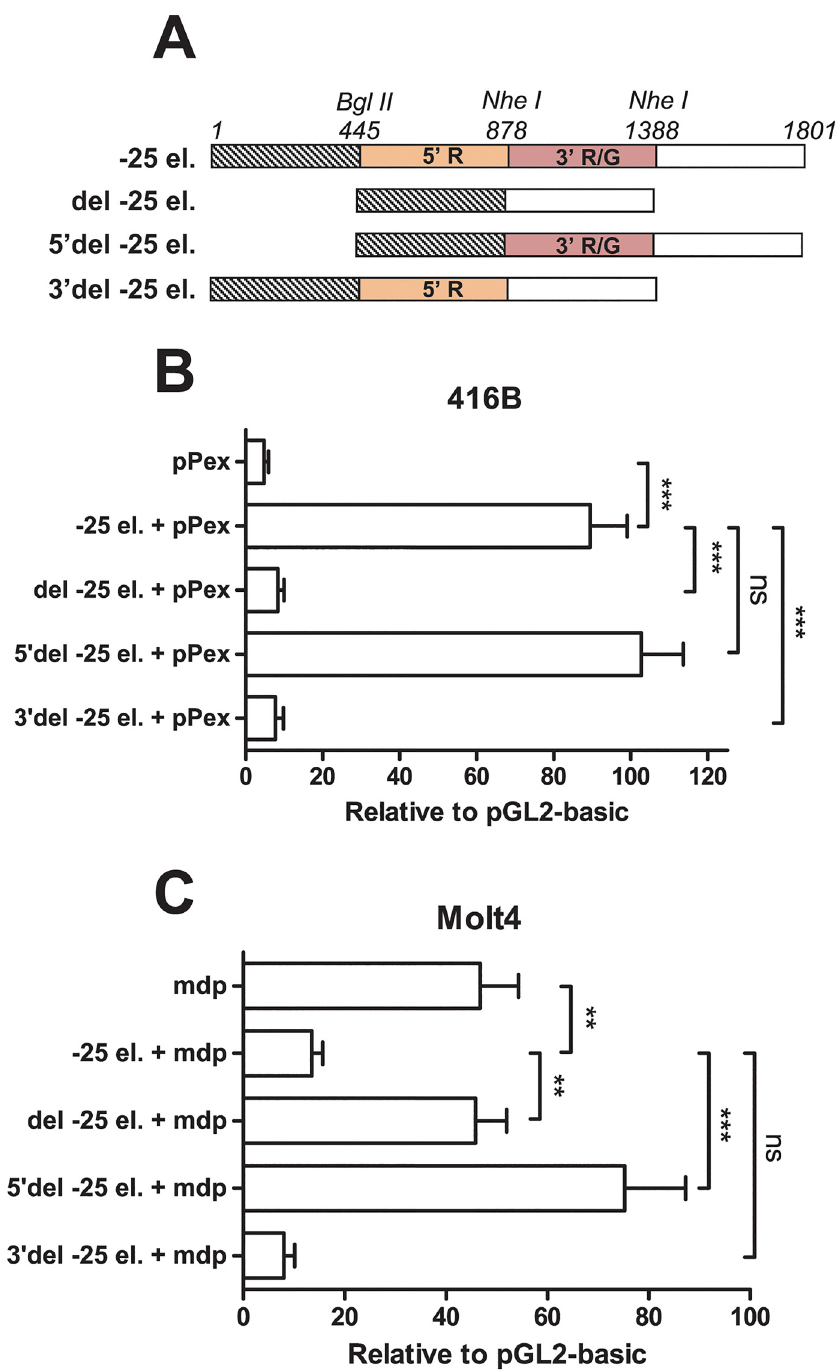
Fig 2. Dual myeloid enhancer and T-cell repressor activity of element -25. A) Diagram of element -25 and deletion constructs. 5 ’ T-cell repressor and 3 ’ myeloid enhancer modules of element -25 (-25 el.) are coloured in orange and red, respectively. The presence of the conserved 5 ’ RUNT (5 ’ R), 3 ’ RUNT and GATA (3 ’ R/G) motifs is indicated. Three deletion constructs (del -25 el., 5 ’ del -25 el. and 3 ’ del -25 el.) were produced by restriction enzyme digestion using BglII (position 445) and NheI (positions 878 and 1388). B, C) Independent myeloid enhancer and T-cell repressor activities of 2 modules within element -25. Deletion constructs were stably transfected together with either LMO2 proximal (pPex) or intermediate (mdp) promoter elements in myeloid progenitors 416B (B) and T-cells Molt4 (C), respectively. In all cases, mean and standard error of the means (SEM) for at least two independent stable transfections (each one performed at least